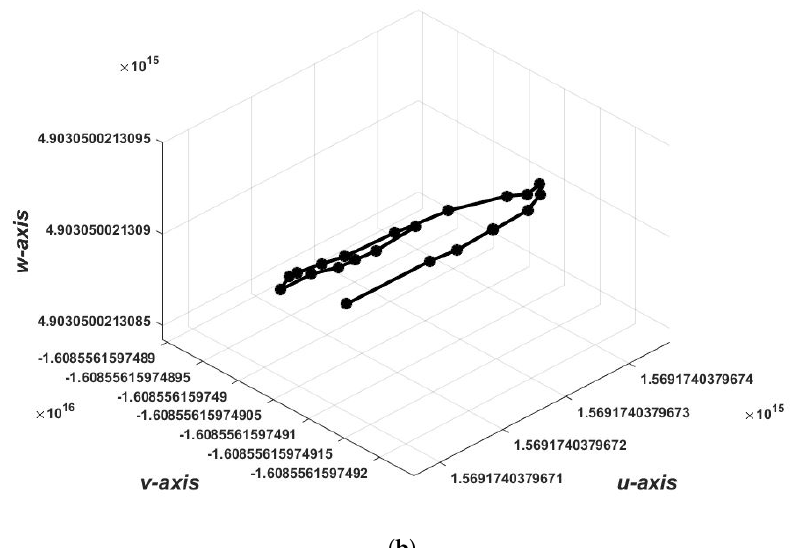
Figure 8. Very different user templates (in the shape of spiral curves) generated from the same biometric data (fingerprint) ( a ) Template generated for a user, ( b ) Template generated for the same user by using different